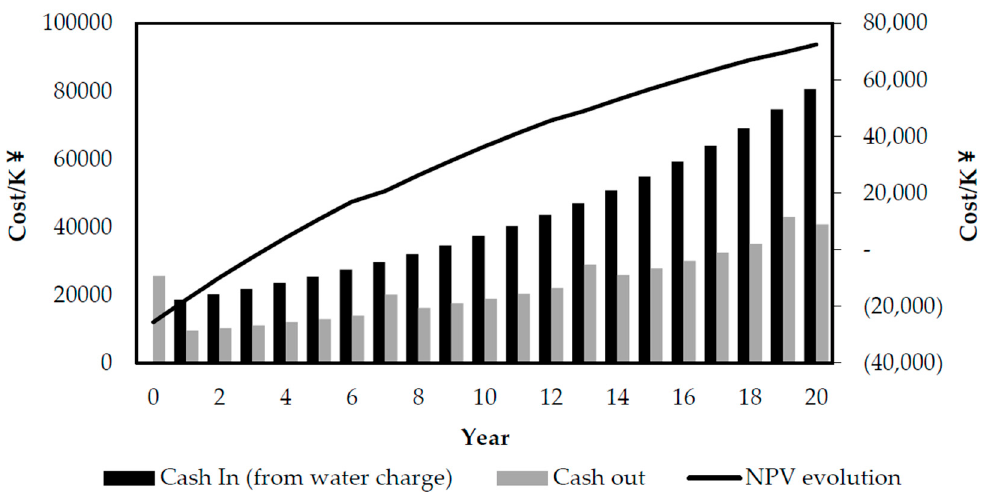
Figure 5. Net present value (NPV) calculation result.